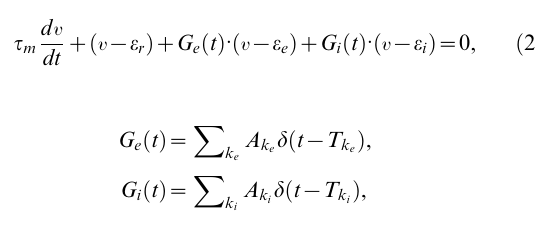
Figure 1 is a schematic diagram of the representative leaky integrate-and-fire neuron from the population receiving the combination of driver and balanced inputs. For the sake